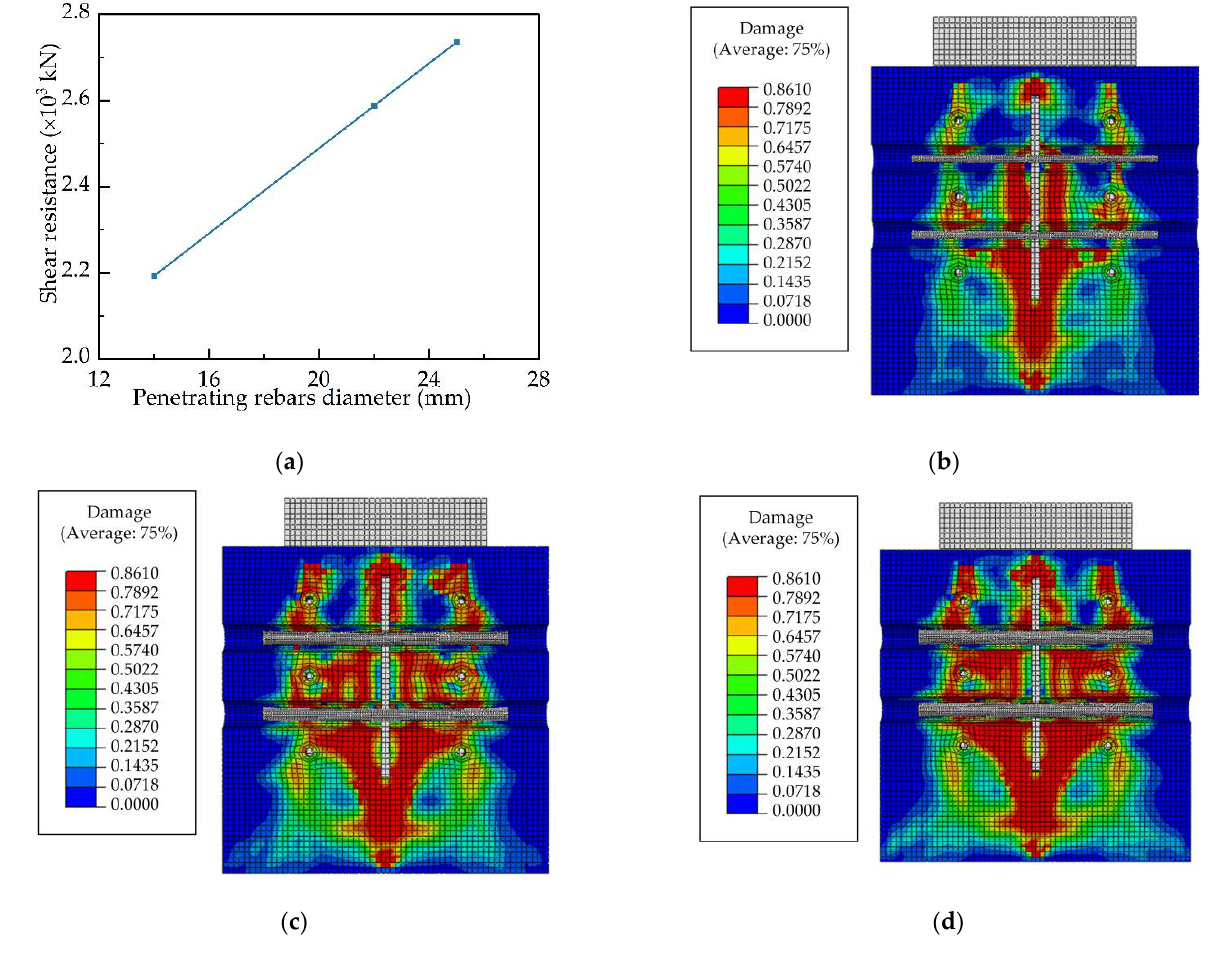
Figure 22. Influence of penetrating rebars’ diameter: ( a ) shear resistance; ( b ) compressive damages cloud map of 14 mm rebar; ( c ) compressive damages cloud map of 22 mm rebar; ( d ) compressive damages cloud map of 25 mm rebar.